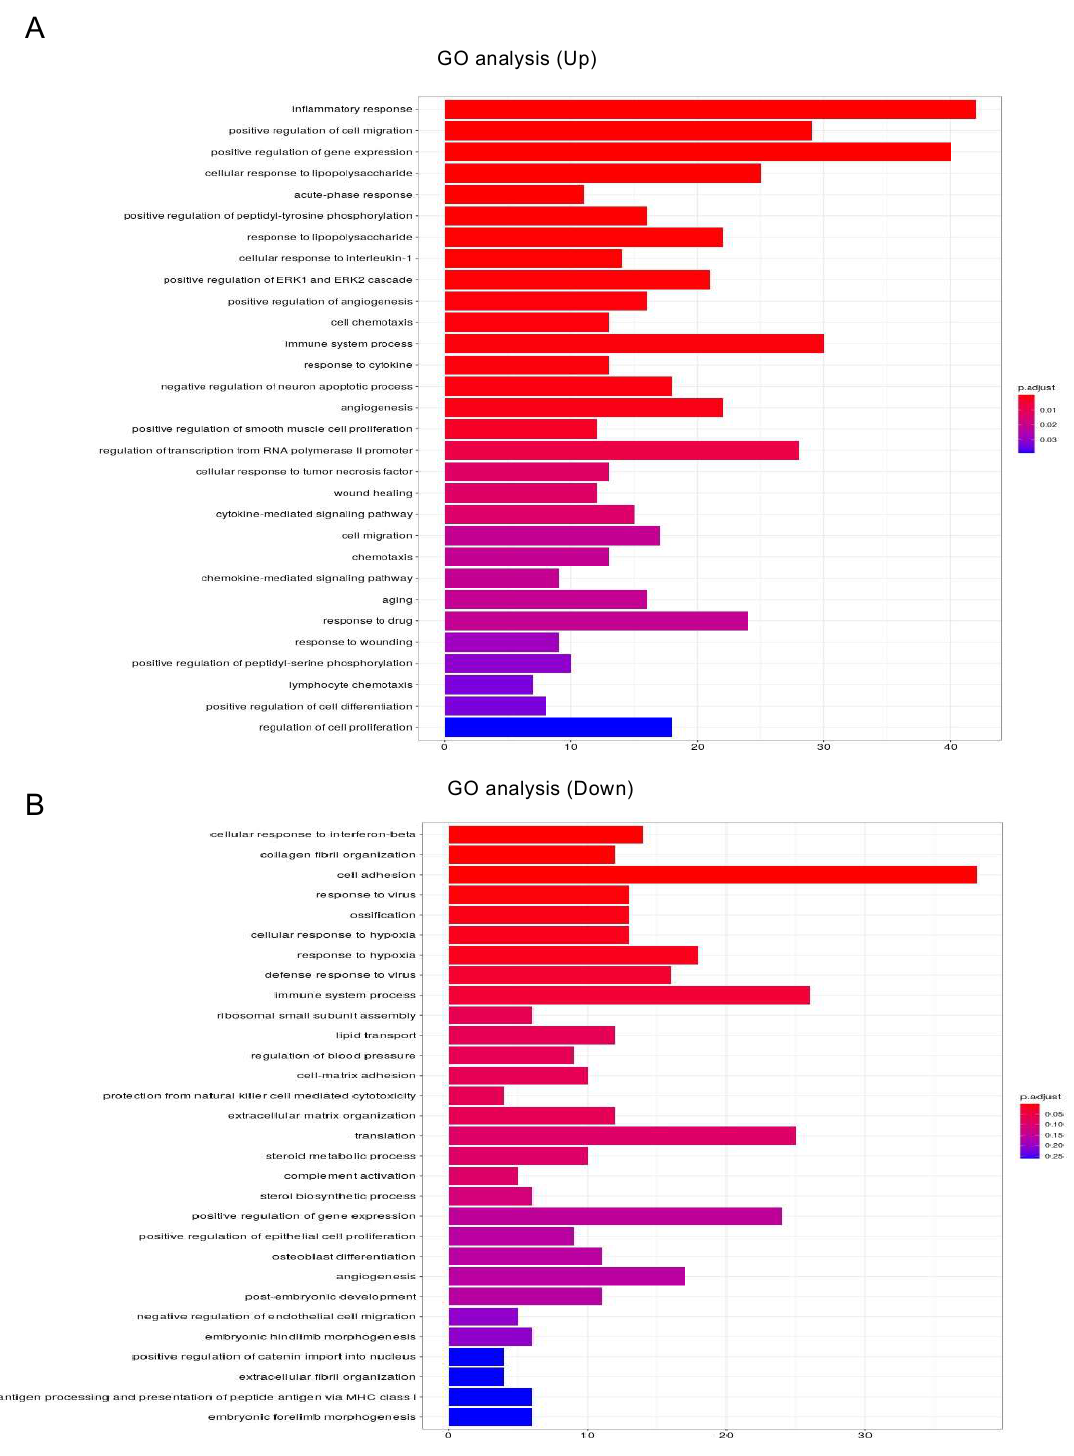
Figure 5. GO enrichment analysis and Ingenuity Pathway Analysis (IPA) of DEGs in 2D- and 3D- cultured 3T3-L1 cells. Upregulated ( A ) and downregulated ( B ) mRNA-enriched biological functions were validated by GO analysis.